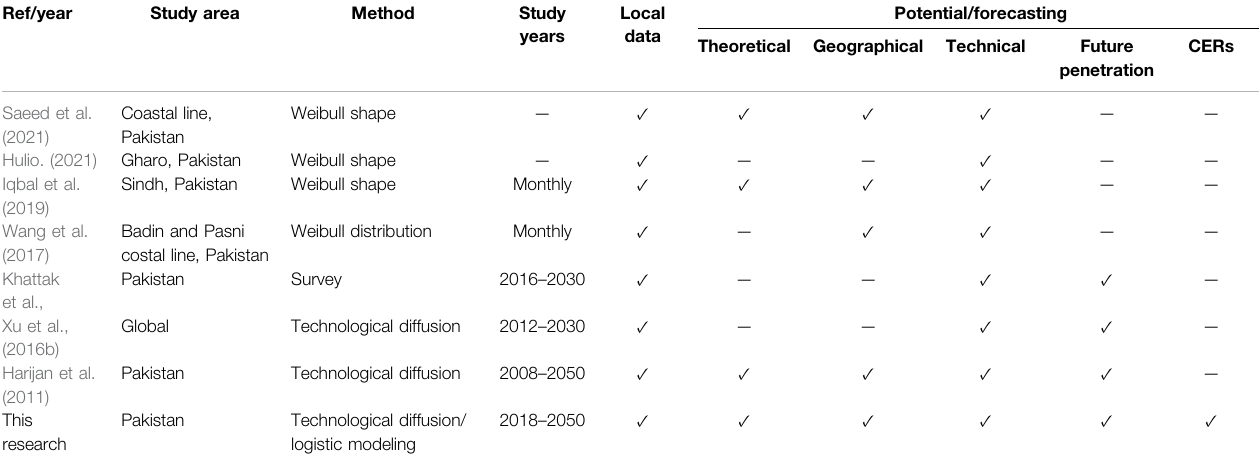
TABLE 1 | Summary of the literature focused on the potential and forecasting of wind energy.